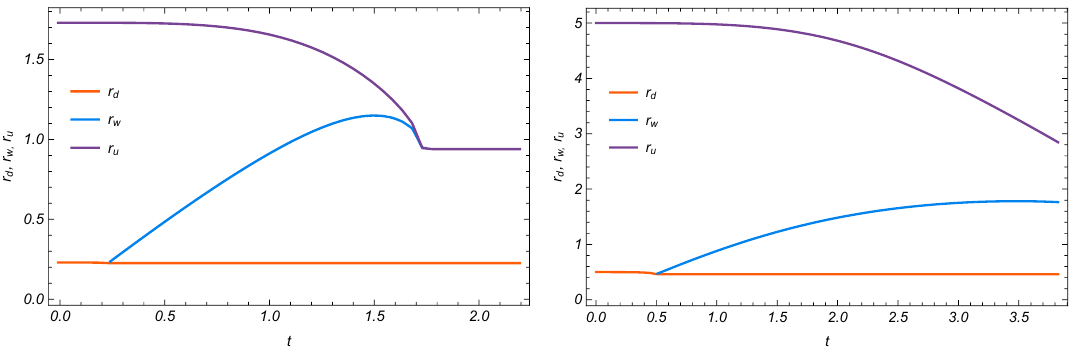
(cid:20) r (cid:20) r w u .